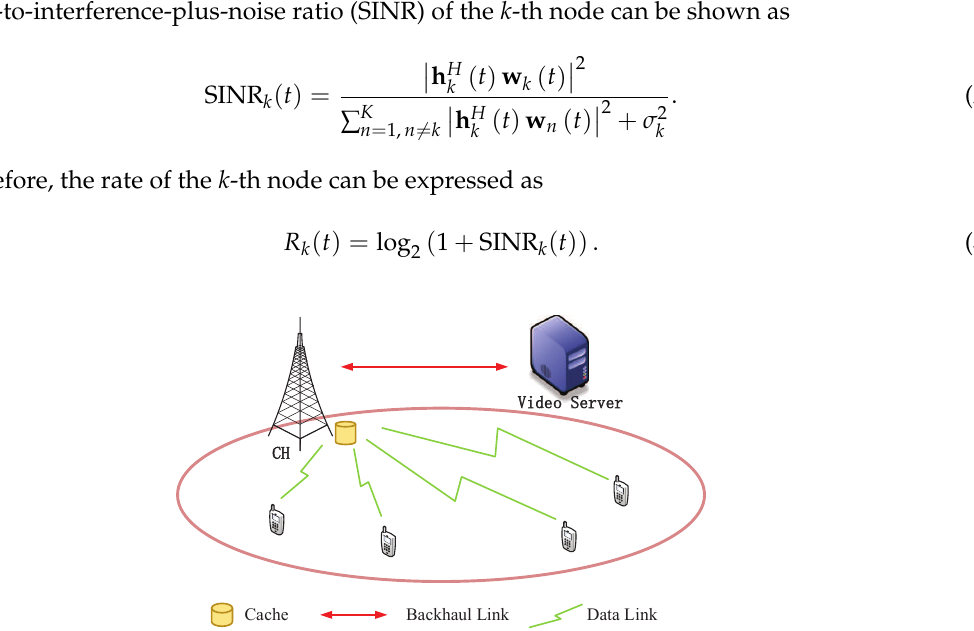
Figure 1. The CH with local cache capacity can provide K nodes with on-demand video services. If the required videos are cached in the local storage, the CH will directly serve the nodes with its local cache. Otherwise, the CH will deliver the required videos from the video server via backhaul